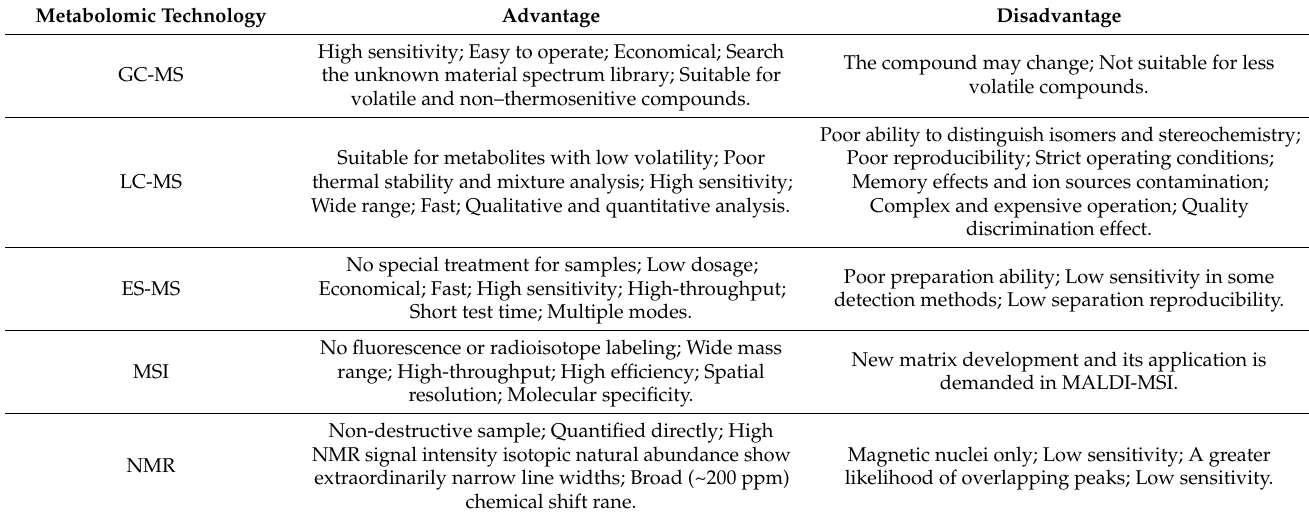
Table 1. Advantages and disadvantages of the analysis technologies for